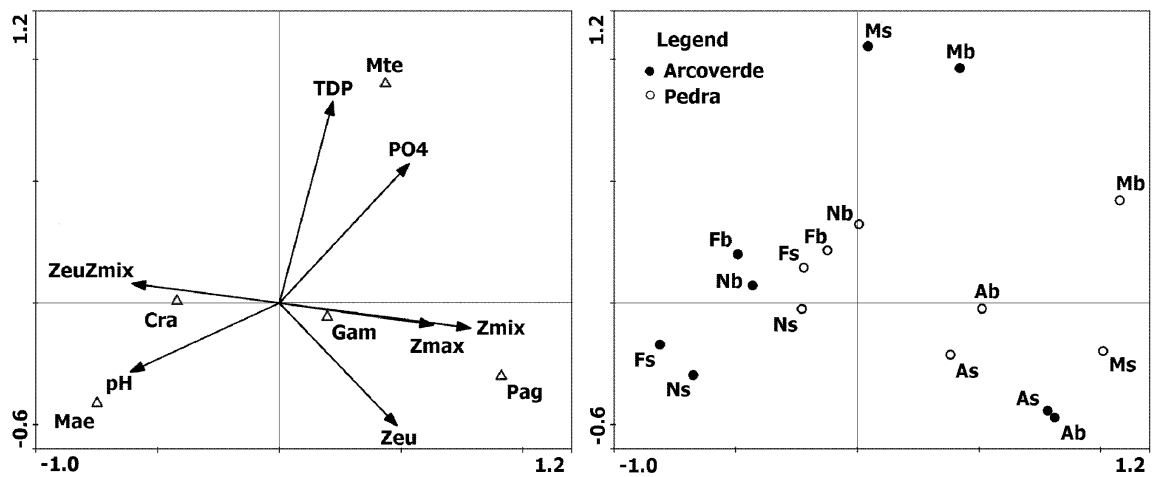
Fig. 4 – CCA performed for the main species of plankton algae and significant abiotic variables in the Arcoverde and Pedra reservoirs, Pernam- buco State, Brazil; Cyanobacteria – Cra: Cylindrospermopsis raciborskii ; Gam: Geitlerinema amphibium ; Mae: Microcystis aeruginosa ; Mte: Merismopedia tenuissima ; Pag: Planktothrix agardhii ; Abiotic variables – PO4: orthophosphate; TDP: total dissolved phosphorus; Zeu: euphotic zone; Zmix: mixture zone; ZeuZmix: euphotic zone/mixture zone ratio; Zmax: maximal depth; Sampling units are identified with the first letter of the month (A: August; F: February; M: May; N: November) and sampling depth (s: subsurface; b: